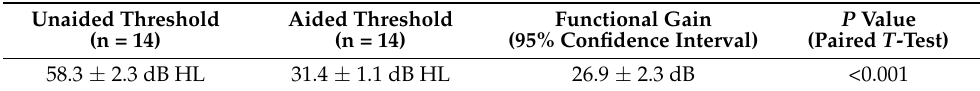
Table 3. Averaged unaided/aided thresholds and functional